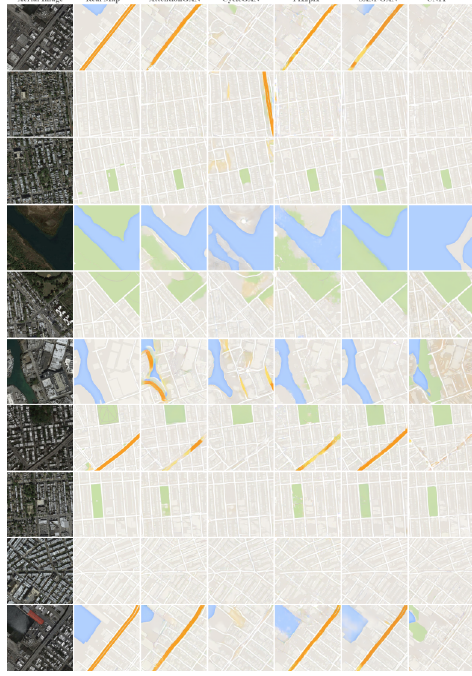
Figure 3. Results of SAM-GAN and each baseline model in terms of aerial image-to-map translation performance, from left to right, aerial images, real maps, results of AttentionGAN, results of CycleGAN, results of Pix2pix, results of SAM-GAN, and results of UNIT.